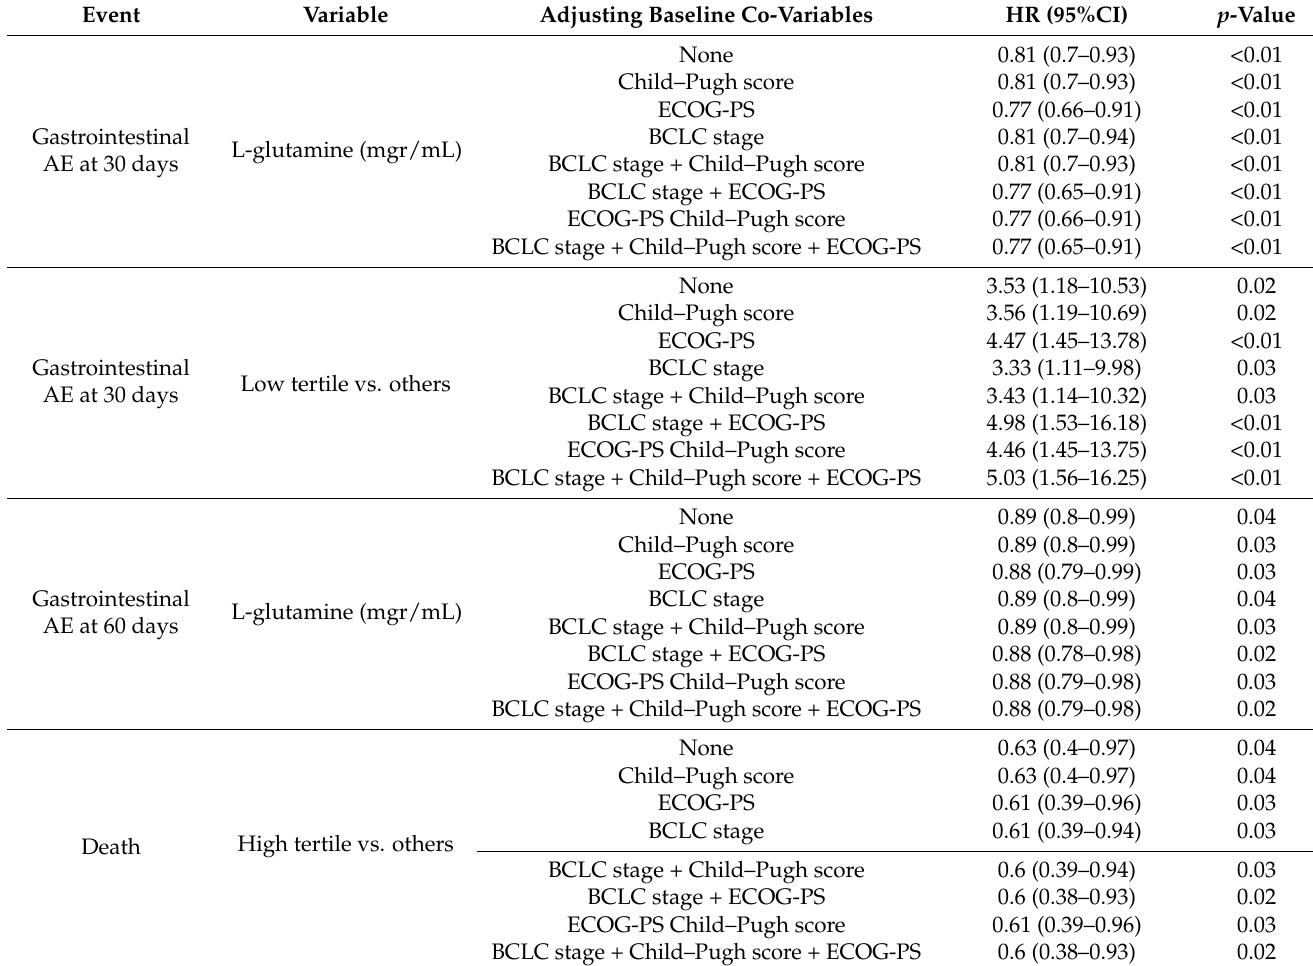
Table 3. Cox regression